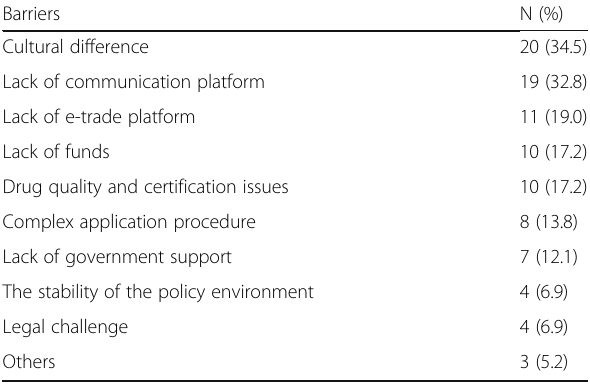
Table 5 Distribution of barriers in BRI Health Cooperation